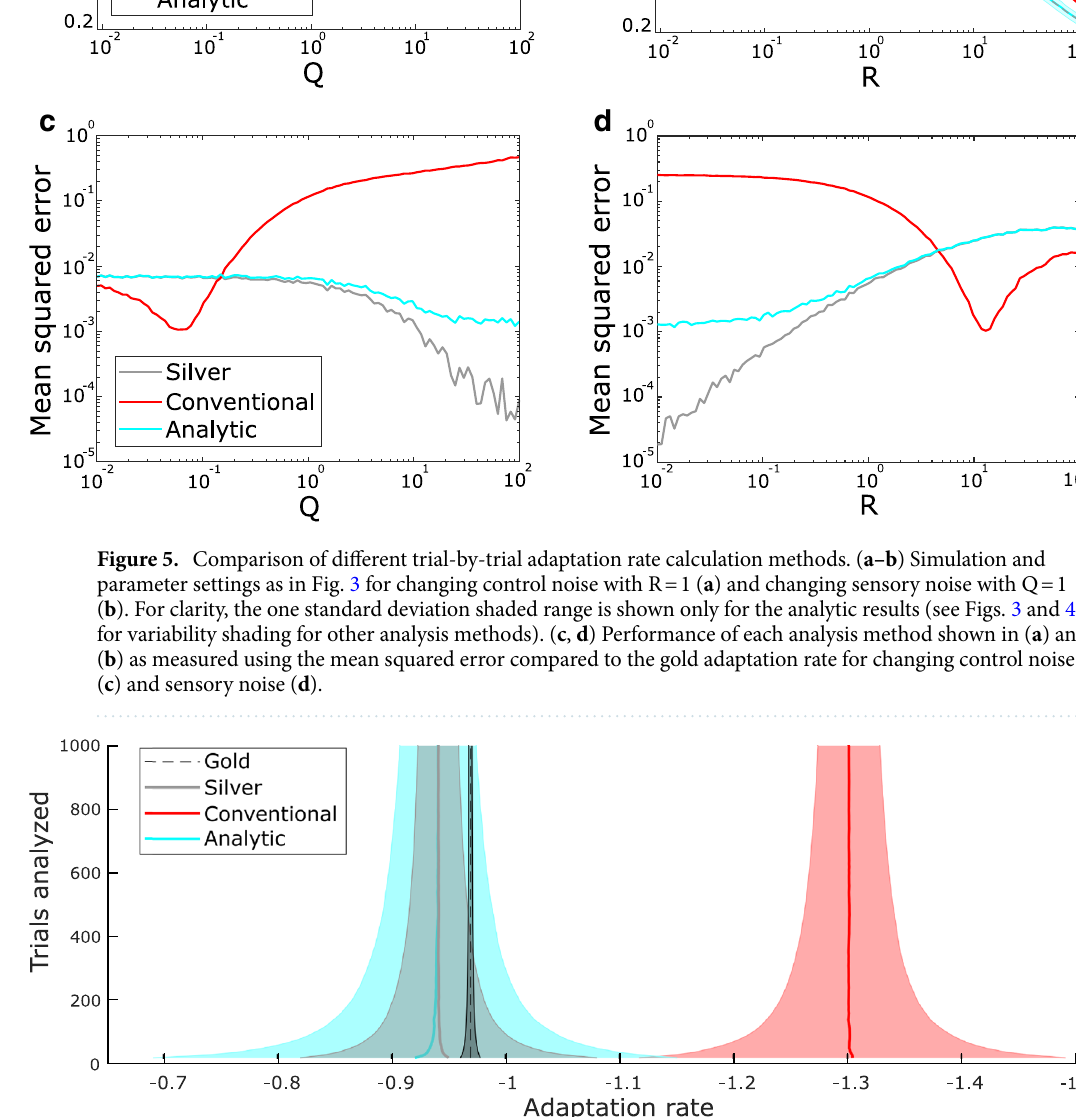
Figure 6. Analyzing more trials reduces variability of results. 10,000 simulations were run with the following parameters: Q = 1 , R = 1 , ξ = 0.1 . Different windows of trials were analyzed on each simulation run with the shaded area indicating one standard deviation of the total